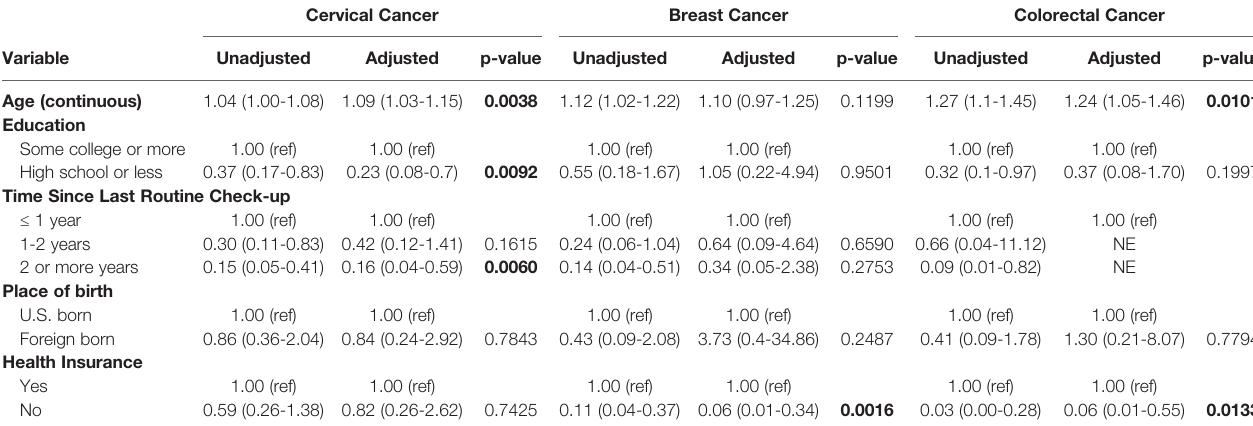
TABLE 3 | Unadjusted and adjusted odds ratios (OR) from logistic regression for factors associated with cervical, breast and colorectal cancer screening. Cervical Cancer